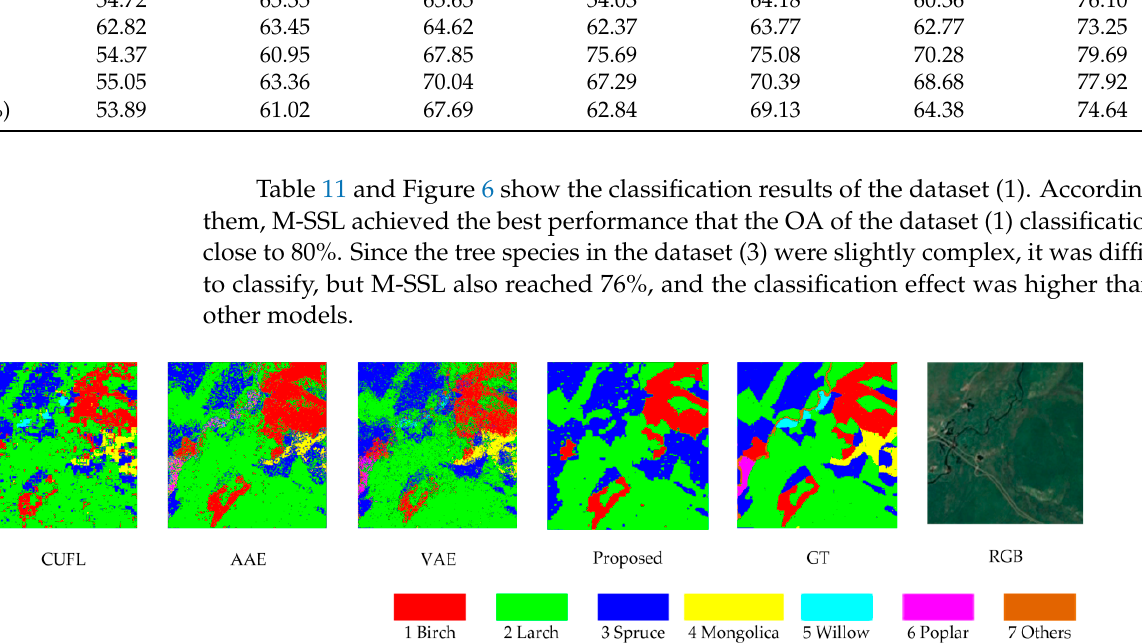
Table 12. The classification accuracy of models for dataset (2).